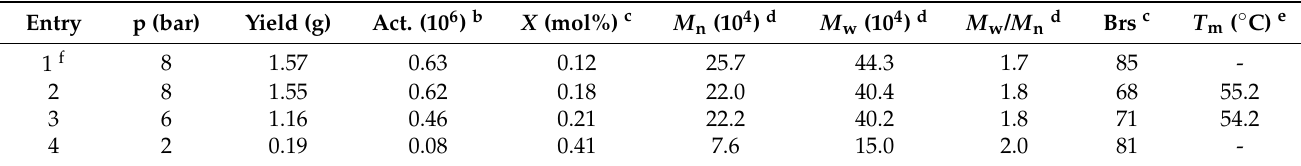
Table 3. Copolymerization of ethylene and UA catalysed by Ipty/ i Pr-Ni a